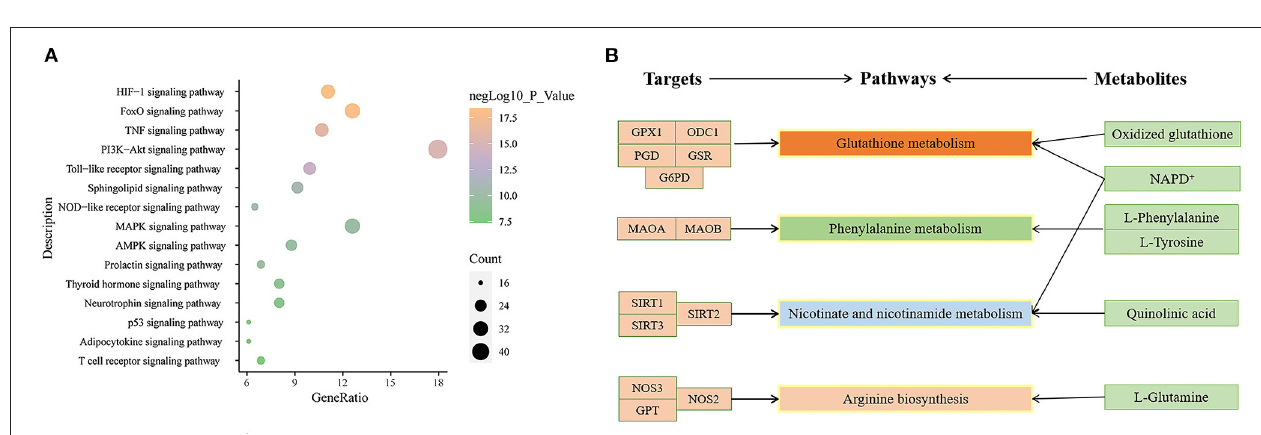
FIGURE 7 | Pathway enrichment. (A) KEGG Pathways; (B) Joint pathway